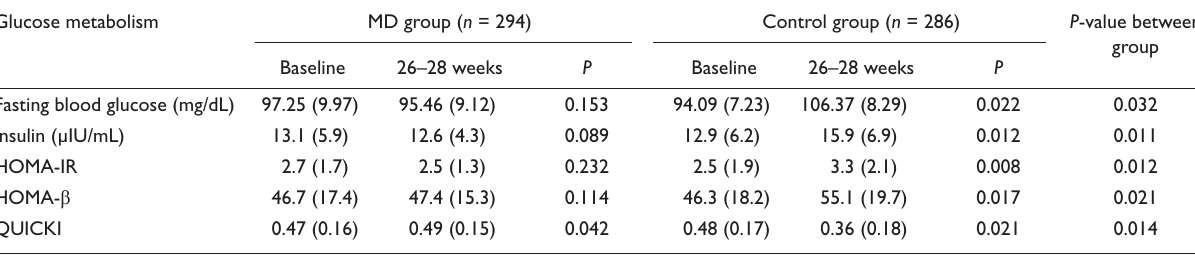
Table 3. Glucose and insulin metabolism of the participants at baseline and gestational 26–28 weeks Glucose